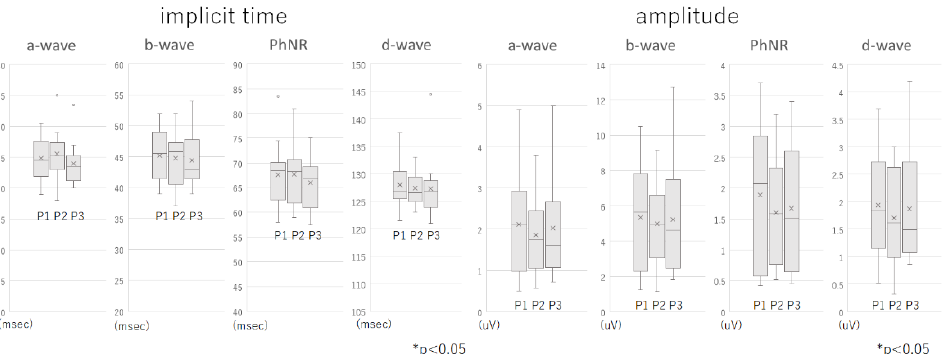
Figure 3. Boxplots of the implicit times and the amplitudes of the intraocular focal macular elec- troretinograms. No significant differences were observed between Phase 1 vs. Phase 2 or between Phase 1 vs. Phase